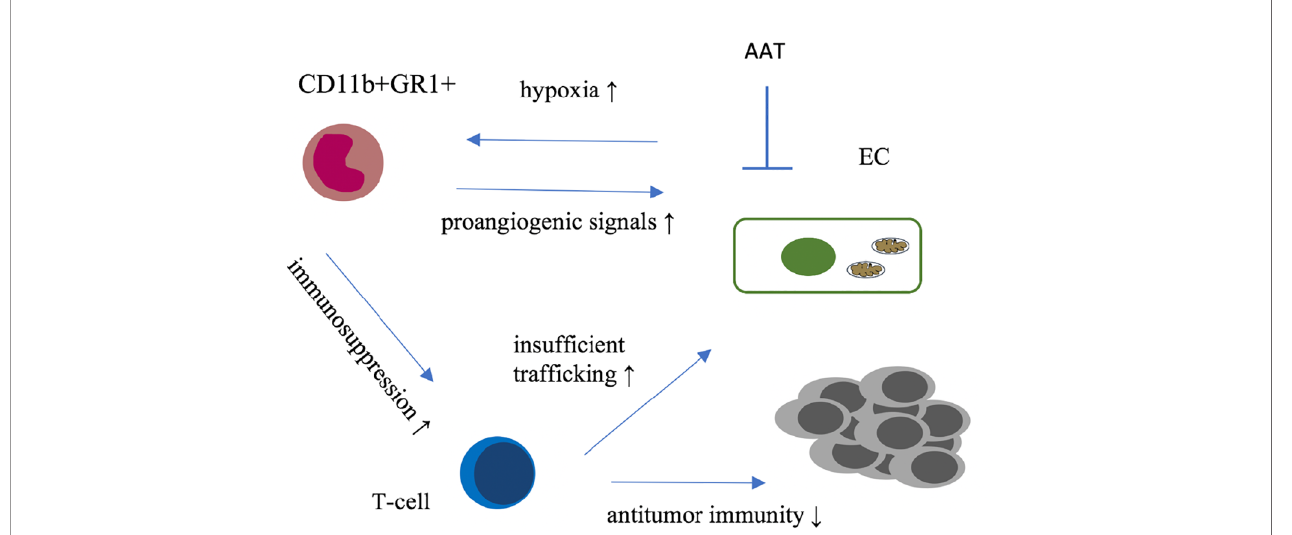
FIGURE 1 | Graphical summary of immune microenvironmental interactions involved in resistance to antiangiogenic therapies. GR1+ cells (i) in fi ltrate tumors as response to AAT-induced hypoxia and secrete proangiogenic factors; (ii) Furthermore these immune cells are suspected to suppress T-cell activity mitigating anti- tumor immunity. Together with insuf fi cient traf fi cking of immune cells along structurally and functionally insuf fi cient blood vessels theses mechanisms provide a rational for complementary anti-tumor activity of vascular normalizing AAT and immunotherapy. AAT, antiangiogenic therapy; EC, endothelial